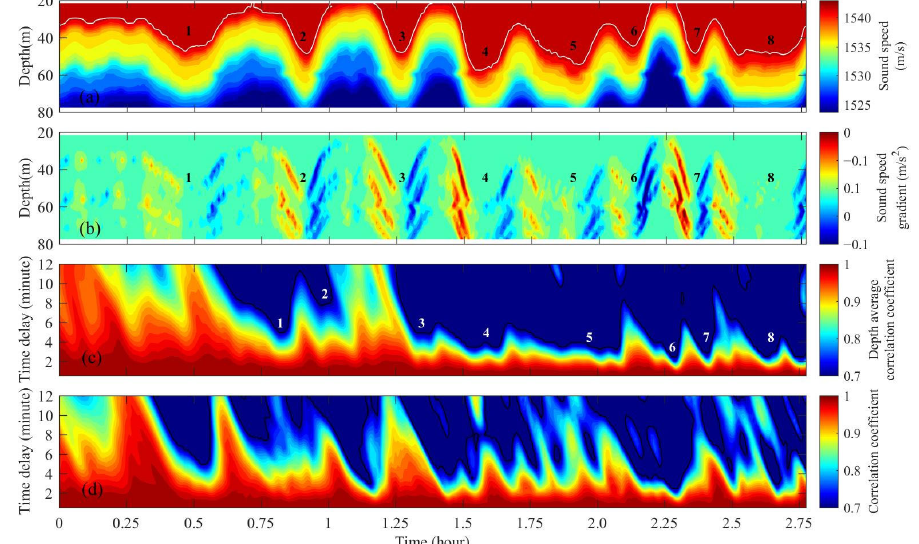
Figure 10. Contour plots of the ( a ) measured sound speed, ( b ) sound ‐ speed gradient, ( c ) simulated depth ‐ averaged (1–20 m) temporal correlation coefficient, and ( d ) simulated temporal correlation coefficient at depth 31 m, over a 2.75 ‐ h period.